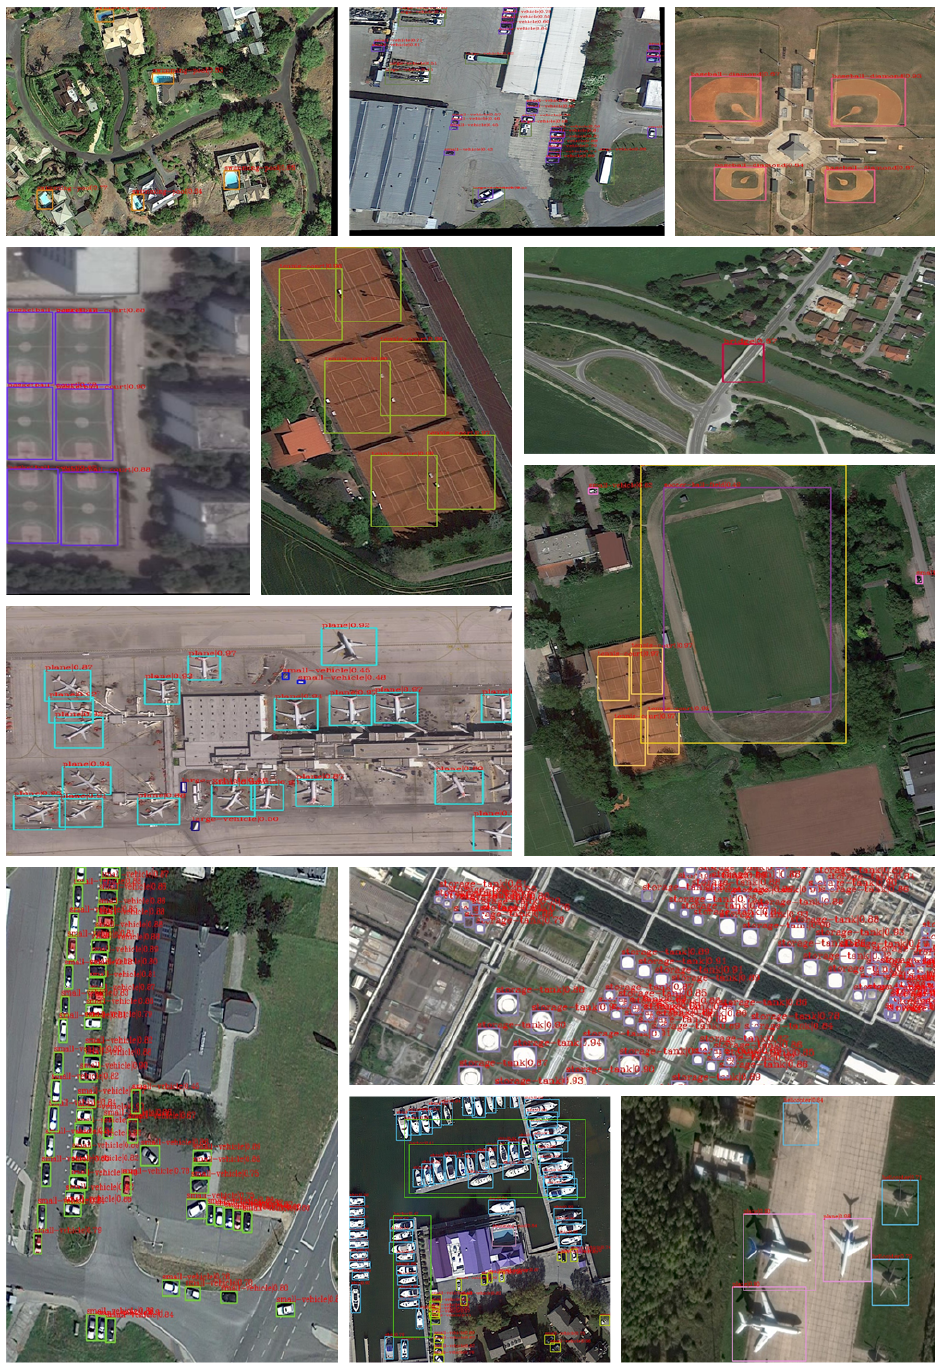
Figure 6. The detection result on DOTA test